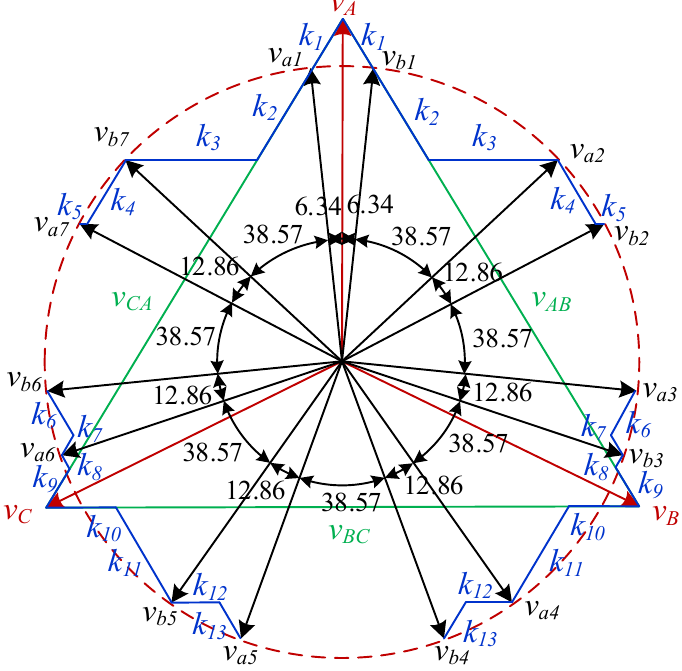
voltage of the six-pulse DBR.